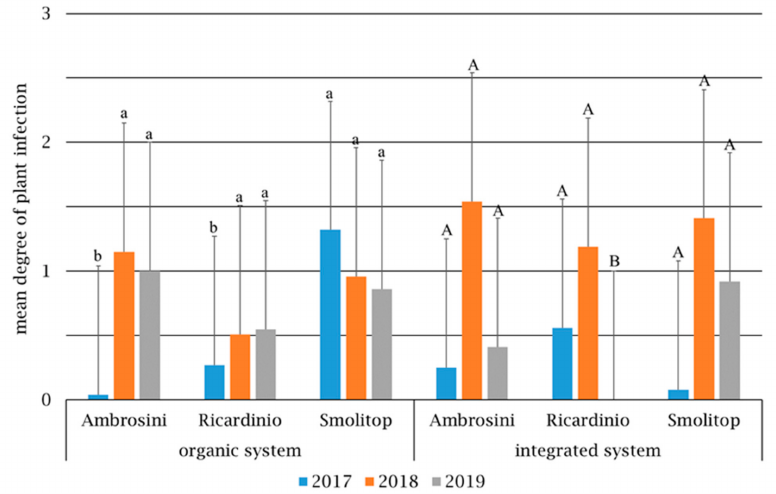
Figure 4. Infestation of maize cobs (mean ± SEM) by Fusarium species of three maize varieties in the years 2017–2019 in two cultivation systems; different letters mean significant differences among varieties (Ambrosini, Ricardinio, Smolitop) in the same year for organic (lowercase letters) and integrated (capital letters) farming, according to the Kruskal–Wallis test at p ≤ 0.05.